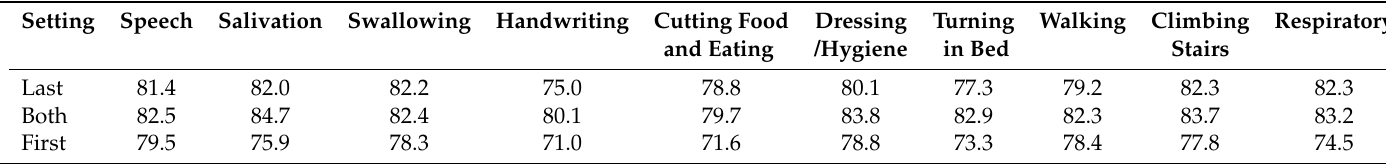
Table 3. Accuracy of DTs for the three settings (only last clinic visit, both, and only first clinic visit). Values depict percentages of correct classification for the different settings and ten ALSFRS items.